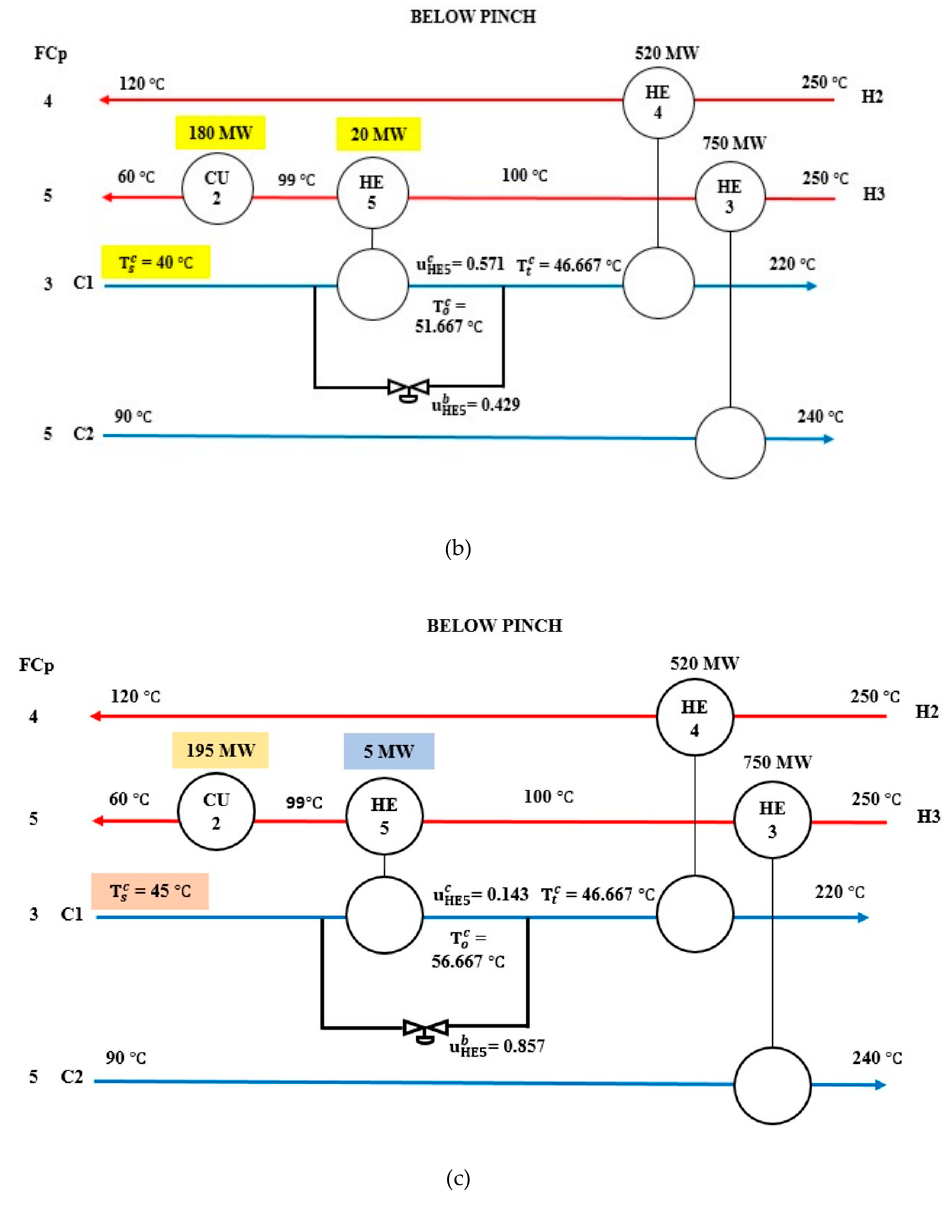
Figure 10. ( a ) HEN design with T S decreased by 5 ℃ for C1. HE5 is designed with a bigger area to accommodate up to 35 MW heat duty; ( b ) HEN design with nominal T S for C1. HE5 is designed with a bigger area and heat duty at 20 MW; ( c ) HEN design with T S increased by 5 ℃ for C1. HE5 is designed with a bigger size and heat duty at 5 MW.